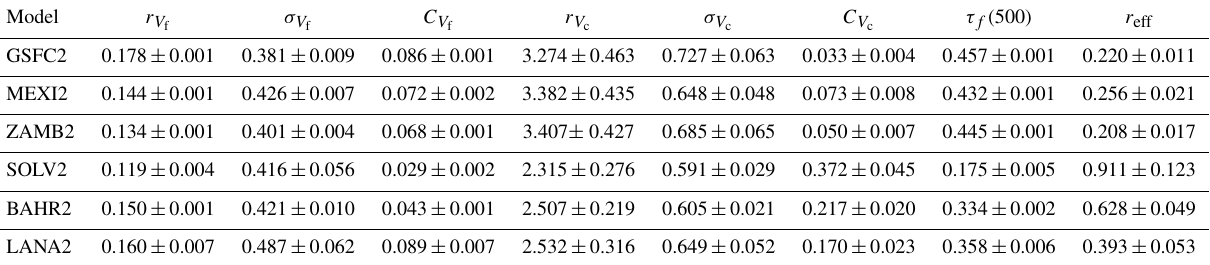
and σ V ) and volume c f